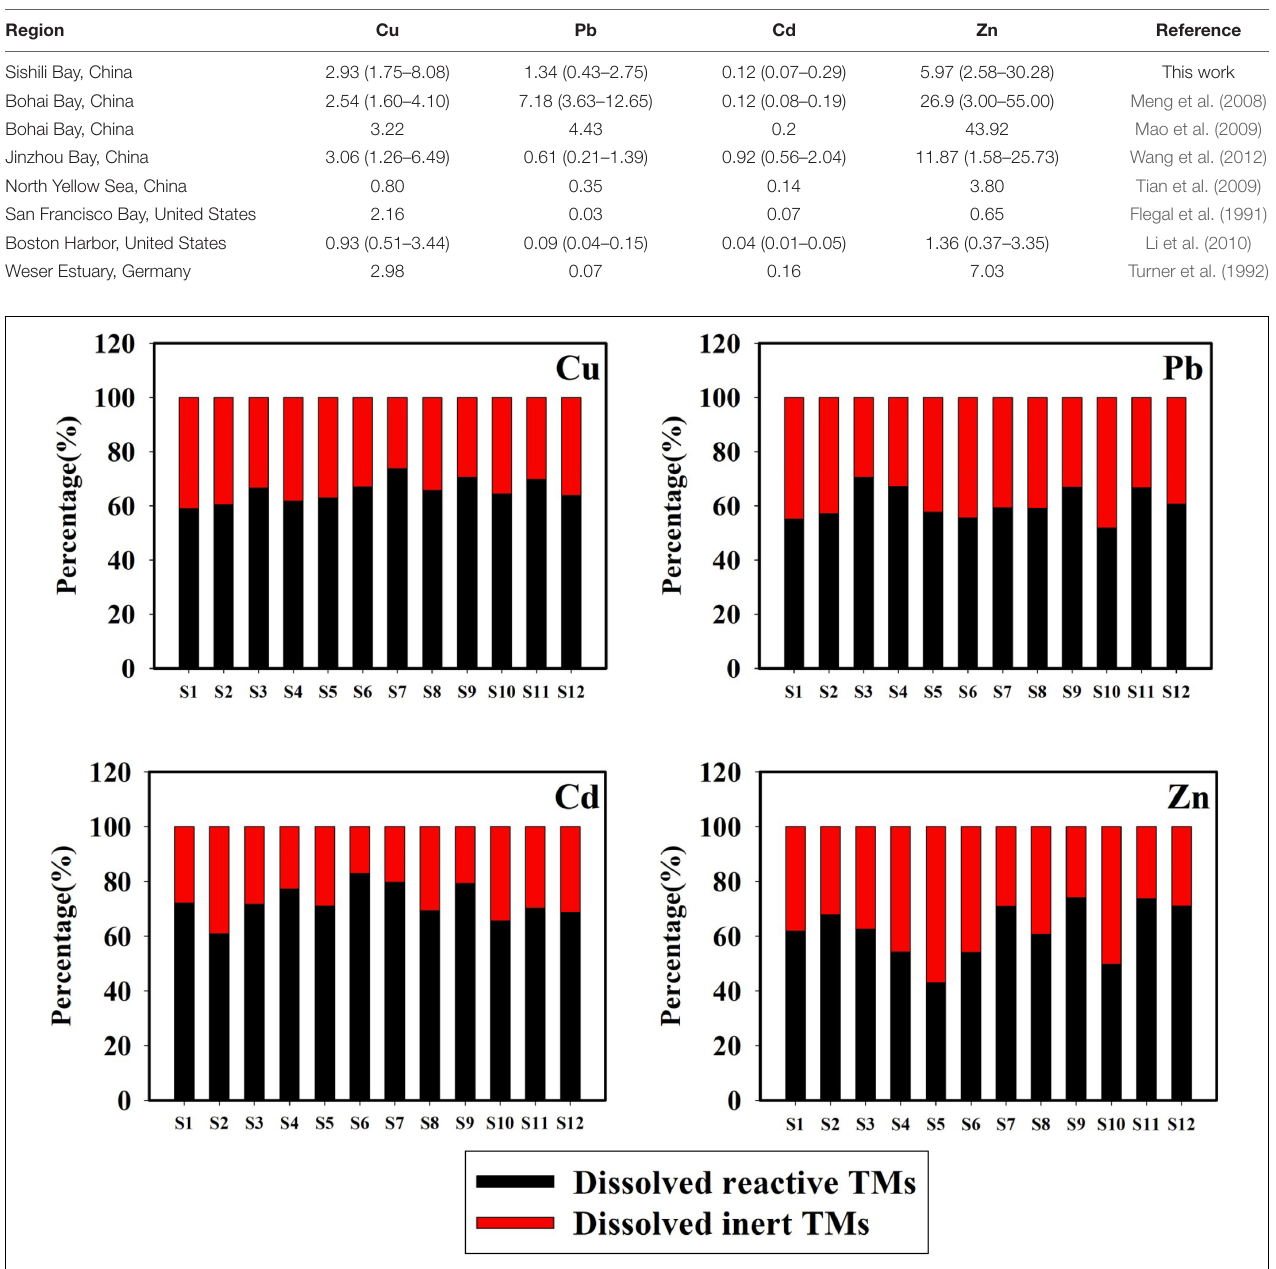
TABLE 1 | Comparison of the annual mean concentrations ( µ g/L) of dissolved Cu, Pb, Cd, and Zn in the seawater of other regions of the world [parentheses present the range of trace metals (TMs)]. Region Cu Pb Cd Zn Reference